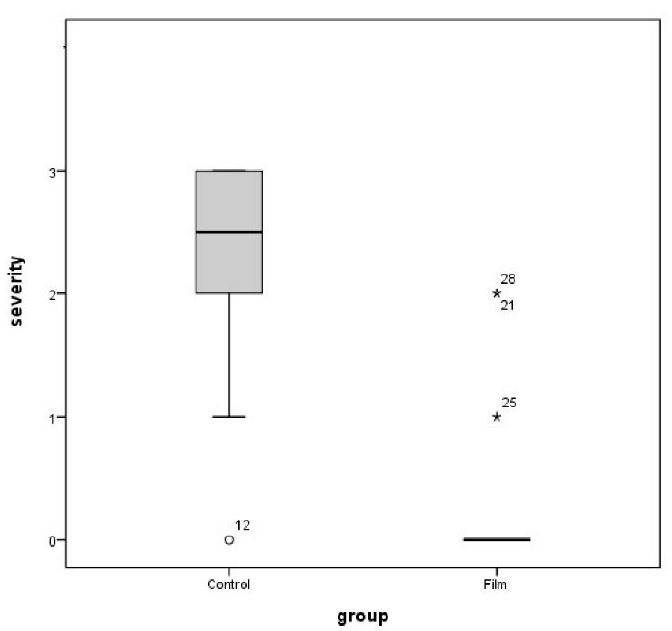
Figure 10. Graphical representations of the adhesion severity scores of the two groups. Median (line within the box), interquartile range (box), and range (error bars) are shown. The differences are statistically significant between the two groups (Mann–Whitney U-shaped test, p < 0.001). Note: represents no adhesion cases in the control group (rat number 12). represents adhesion cases in the test group (rat numbers 21, 25, and 28).